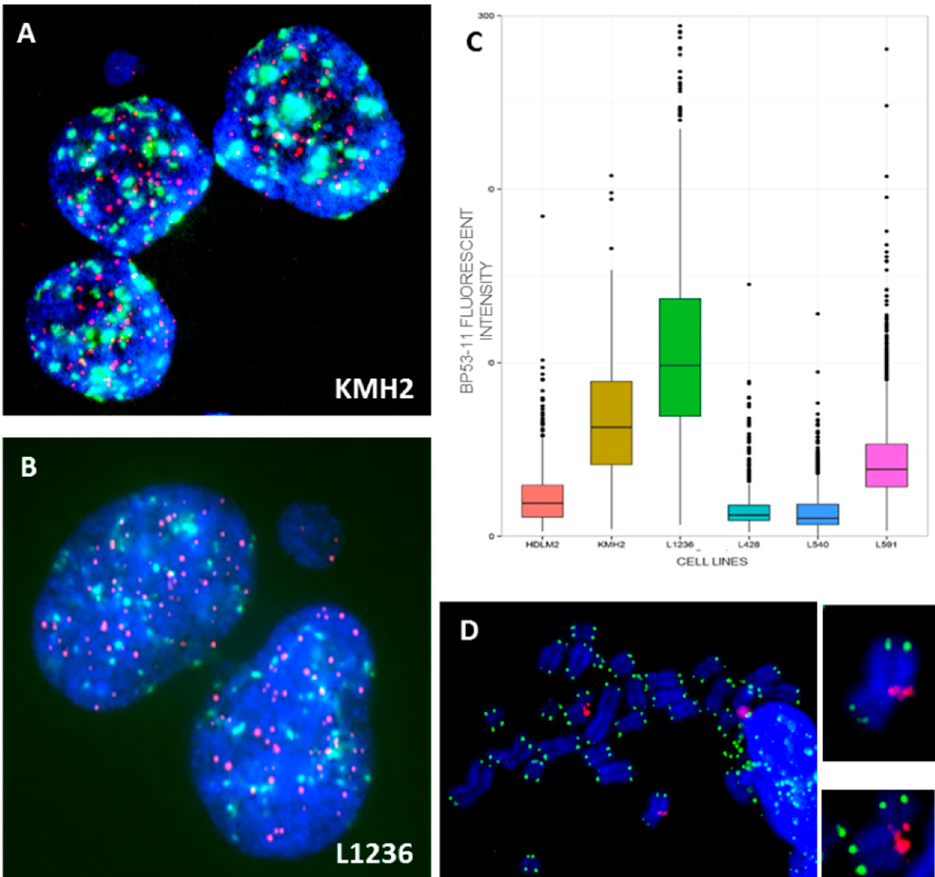
Figure 6. Breakpoints in clonal dicentric chromosomes in KMH2 cells. ( A ) telomere and centromere staining followed by ( B ) M-FISH and ( C ) chromosome classification revealed ( D ) pericentromeric breakpoints in dicentric chromosomes (63× magnification).